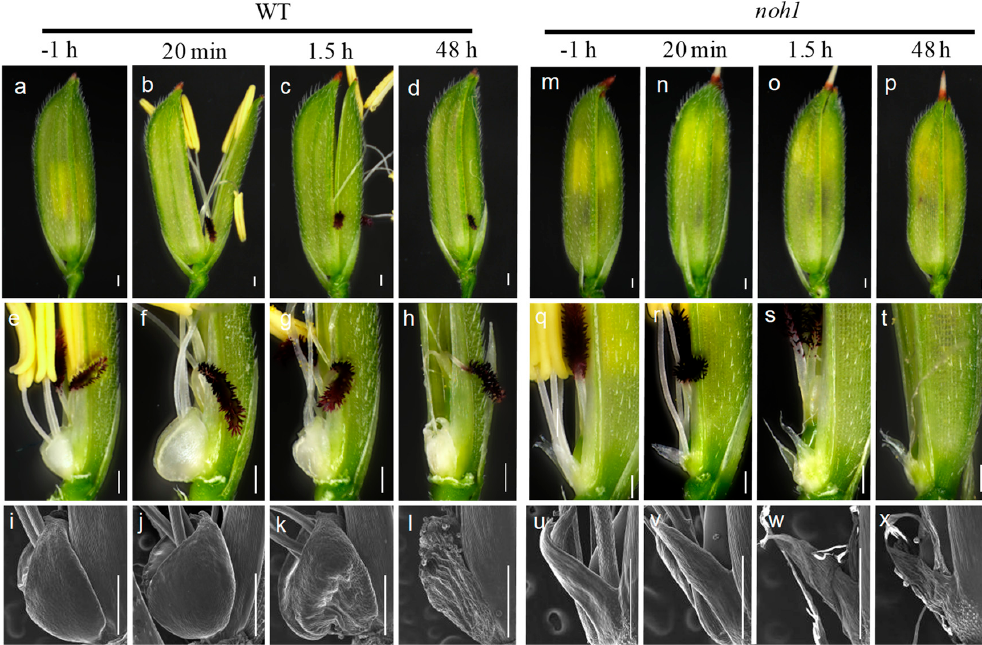
Figure 3. Morphological observation of wild-type (WT) and noh1 mutant florets during flowering; ( a– d ) show successively the WT florets at one hour before opening, 20 minutes after opening, 1.5